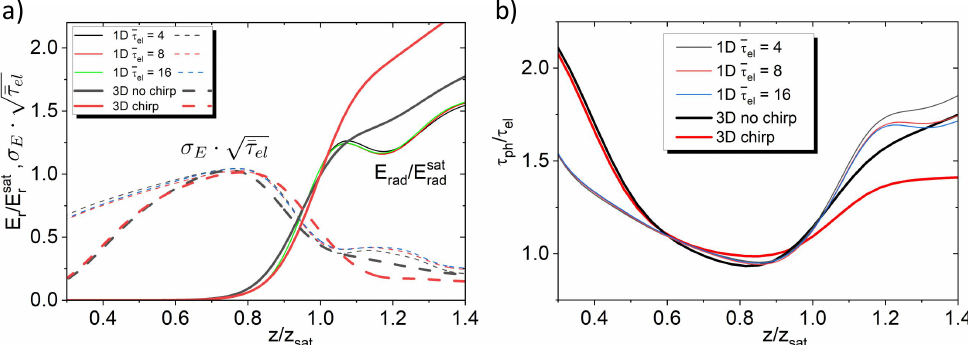
Figure 1. ( a ) Simulated average radiation pulse energy and fluctuations in the radiation pulse energy along the undulator length normalized to the saturation length. The fluctuations are scaled with √ ¯ τ el to compensate for the pulse duration dependence as described below in the text. ( b ) Simulated evolution of the radiation pulse duration along the undulator length. Thin curves show the result of the 1D model for three different electron pulse lengths M ∼ ¯ τ el = 4,8 and 16. The black bold curve shows the 3D model for the pulse length of M ∼ ¯ τ el = 5 without energy chirp, and the bold red curve shows the 3D model including energy